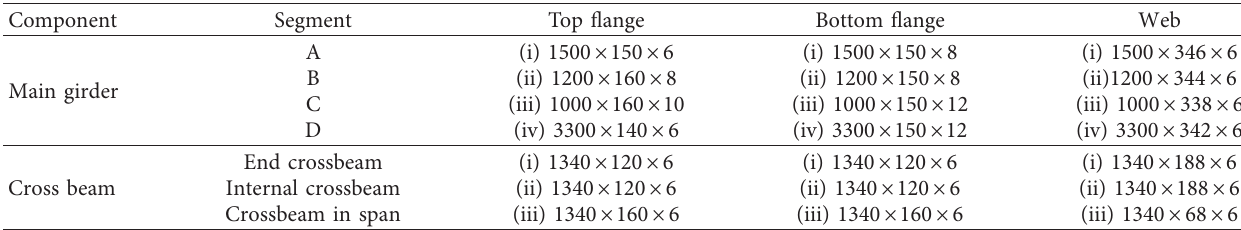
Figure 2: Typical geometry of the bridge model (unit: mm) [23]: (a) vertical view (1/2 span), (b) cross-section, (c) layout of reinforcement, (d) top view (1/2 span), and (e) arrangement of the group studs. Table 1: The detail dimensions of all steel plates (unit: